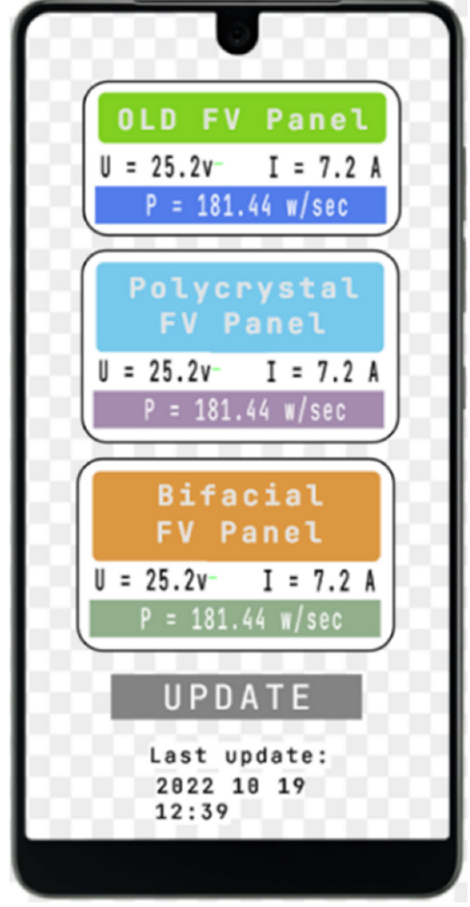
Figure 6. Mobile application image.